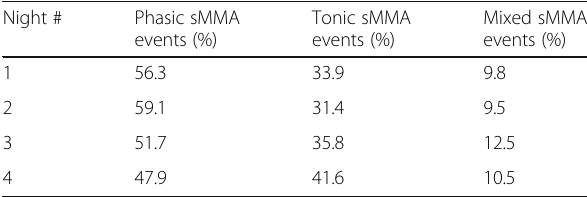
Table 1 Demographic data of the study population No. of participants Females/males Mean age (s.d.)